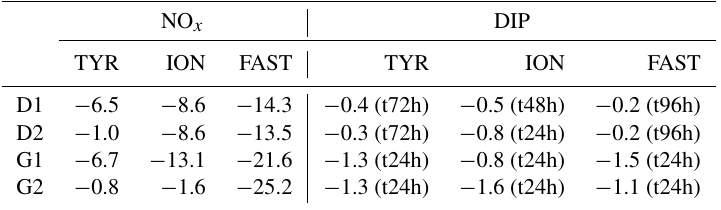
Table 4. Removal rate of nitrate + nitrite (NO x ) and dissolved inorganic phosphorus (DIP) in tanks D and G during the three experiments (TYR, ION and FAST). For NO x , rates were estimated based on linear regressions between maximum concentrations (i.e. after dust en- richment, at t1h or t6h) and final concentrations (t72h for TYR and ION and t96h for FAST). For DIP, rates were estimated based on linear regressions between maximum concentrations (i.e. after dust enrichment at t1h or t6h) and concentrations after stabilization were observed. This sampling time is shown in parentheses. All rates are expressed in nmolL − 1 h − 1 .